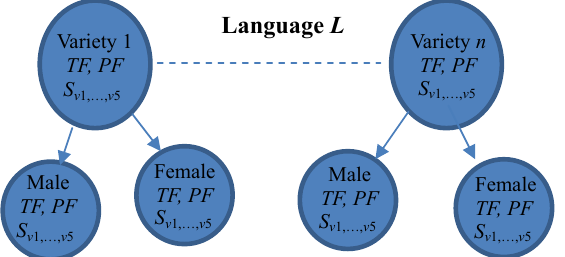
Fig. 3 Language variety classes and gender subclasses for a language L [44] .